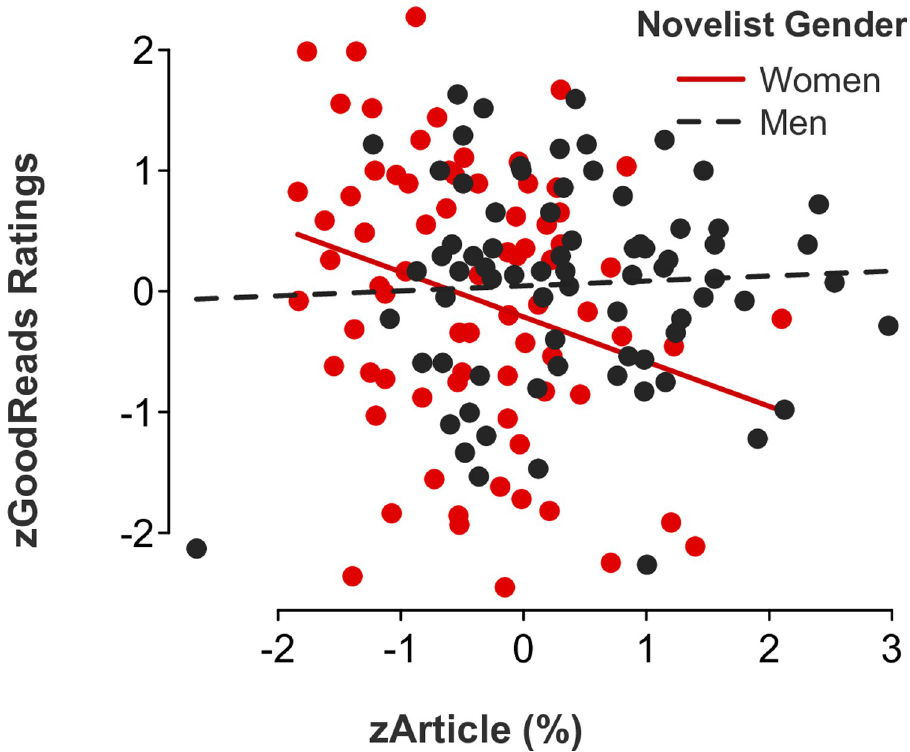
Fig 11. Novel ratings as a function of article use and novelist gender.